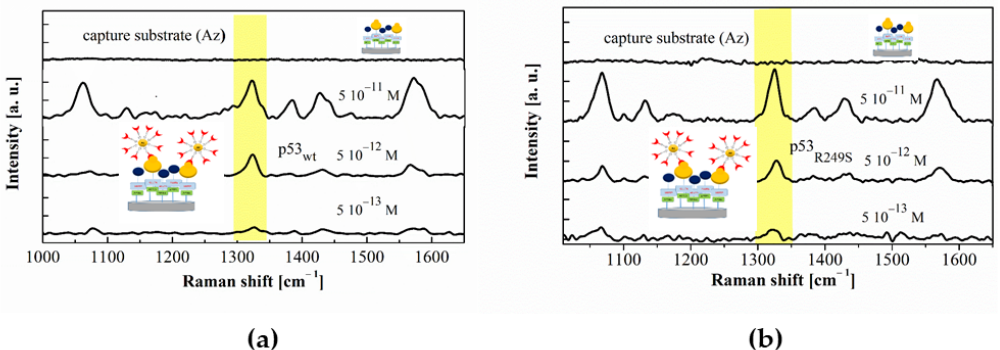
Figure 6. ( a ) Raman spectra of the capture substrate (functionalized with Az and after the incubation with the 4-ATP-NP-p53 probe charged with p53 wt at di ff erent concentrations. ( b ) Raman spectra of the capture substrate (functionalized with Az and after the incubation with the 4-ATP-NP-p53 probe charged with p53 R249S at di ff erent concentrations. The yellow band highlights the Raman marker peaked at 1328 cm − 1